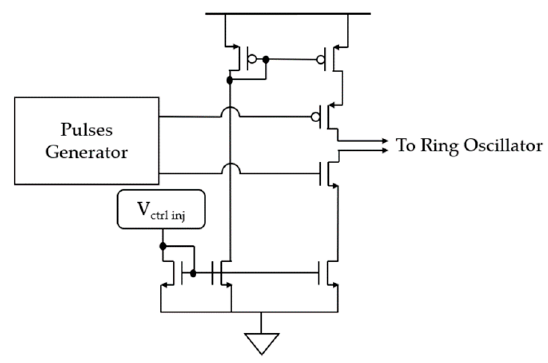
Figure 4. V/I converter schematic.